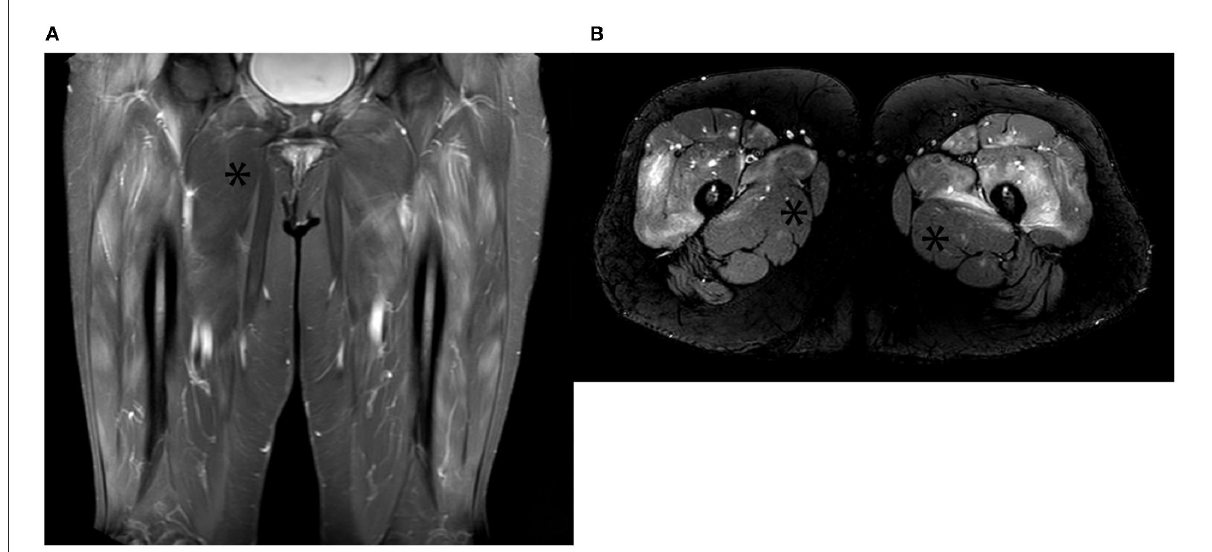
FIGURE2 (A) Contrast-enhanced coronal STIR images of bilateral upper thigh muscles (anterior compartment) with extensive hyperintensities indicating features of muscle edema. The asterisk demonstrates the spared adductor muscle; (B) Axial STIR images of the same patient showing classical edema signal pattern (high signal intensity) in the anterior compartment of both upper thigh muscles. Inflamed muscles demonstrate contrast enhancement. The asterisk demonstrates the spared adductor